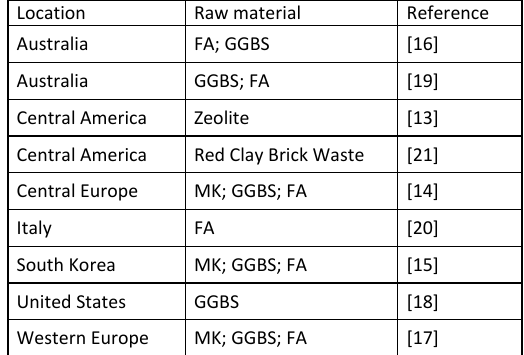
Table 1. Comparison of published LCA